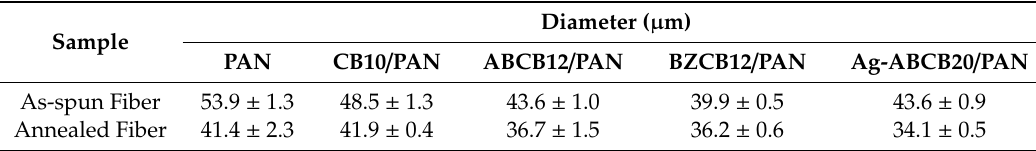
Figure 6. SEM images of as-spun and annealed fibers. As-spun fibers: ( a ) PANB, ( b ) CB10/PAN, ( c ) ABCB12/PAN, ( d ) BZCB12/PAN, and ( e )Ag-ABCB20/PAN. And annealed fiber: ( f ) PANB, ( g ) CB10/PAN, ( h ) ABCB12/PAN, ( i ) BZCB12/PAN, and ( j ) Ag-ABCB20/PAN. Table 1. Diameters of as-spun and annealed fibers.